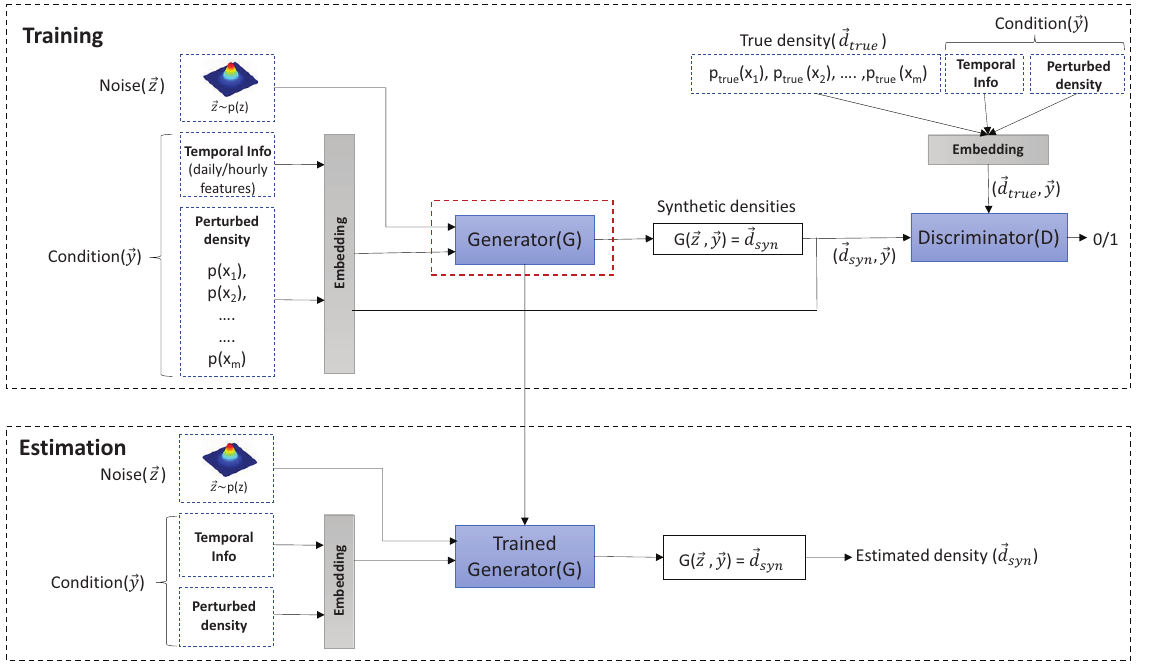
Figure 2. The overall neural network structure for estimating the density distribution of LBS users under Geo-I